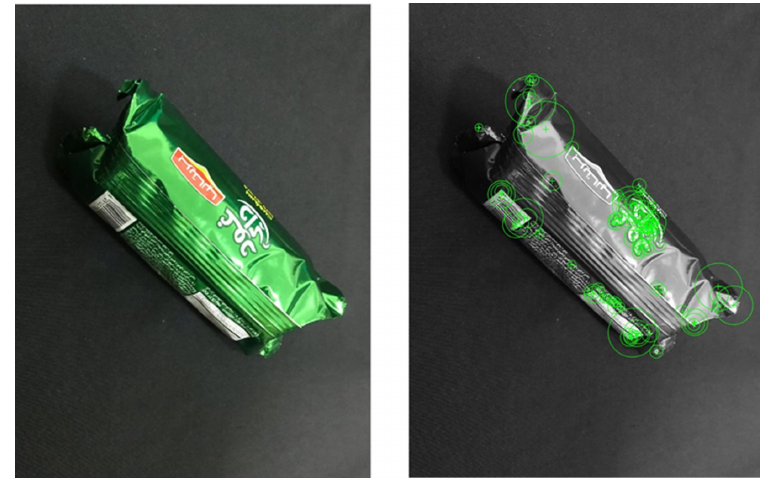
Figure 16. SURF features extracted of an item in cart.